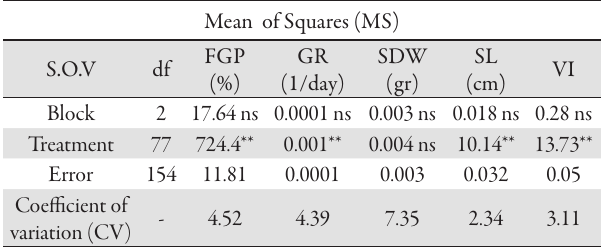
Tab. 2. The ANOVA table showing the osmopriming treatment in comparison with control on germination traits of soybean seed (cv.